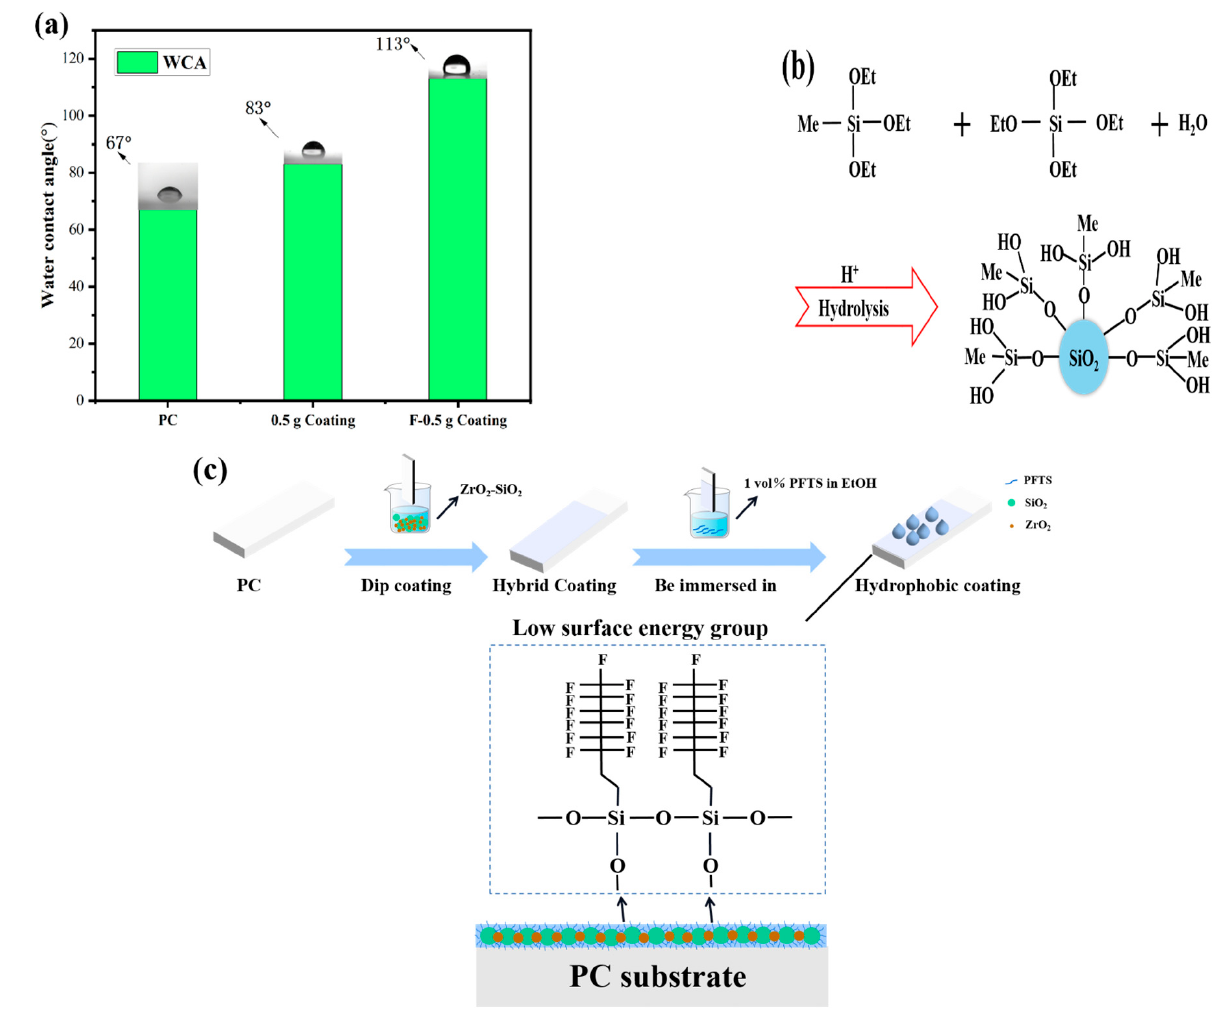
Figure 5. ( a ) WCA of the bare PC, the coating before and after PFTS modification, ( b ) Diagram of MTES/TEOS hydrolysis process, ( c ) Schematic illustration of the mechanism of surface hydrophobicity.